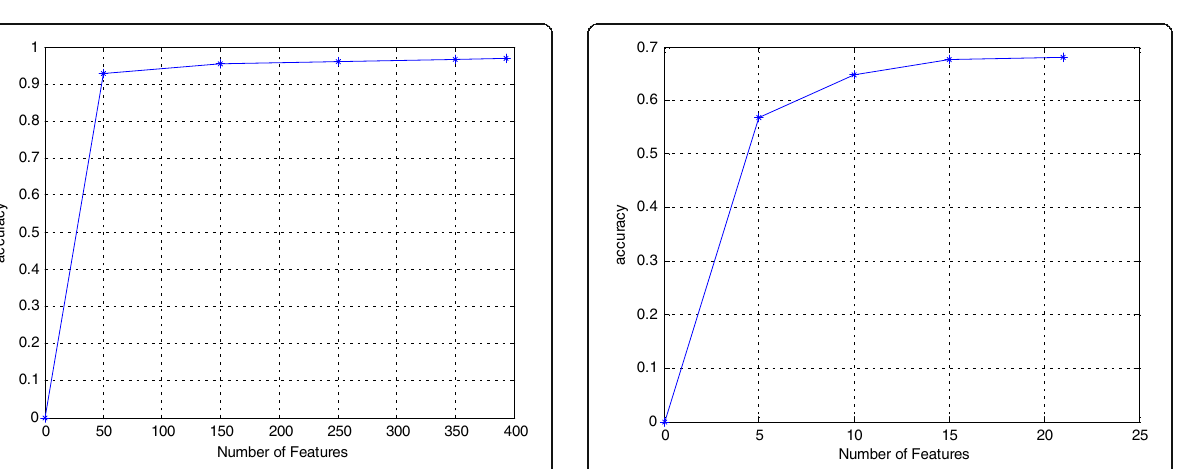
Fig. 6 Recognition rates with different number of shape features